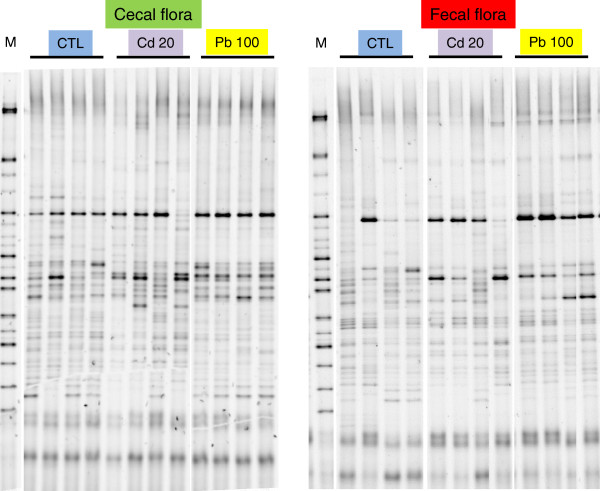
DGGE profiles revealed microbial diversity in the cecum content and fecal pellets of mice exposed for 8 weeks to Cd and Pb salts via their drinking water. The figure shows DGGE gels of the V5-V6 hypervariable 16S rDNA region, illustrating the microbiota’s composition in the cecum and the feces of 4 mice treated (or not) with 20 mg L-1 (ppm) of Cd or 100 mg L-1 (ppm) of Pb.